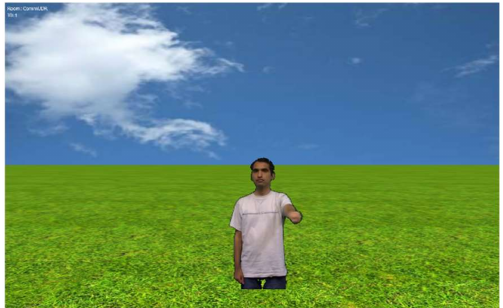
Figure 4. Human avatar projected in the experiment.